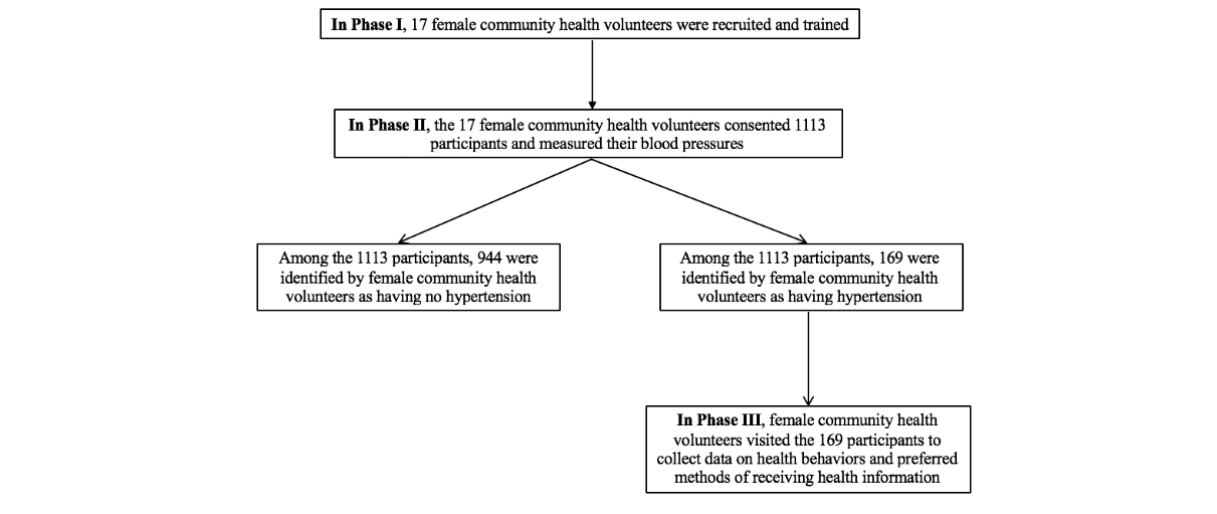
Figure 1. Study flow